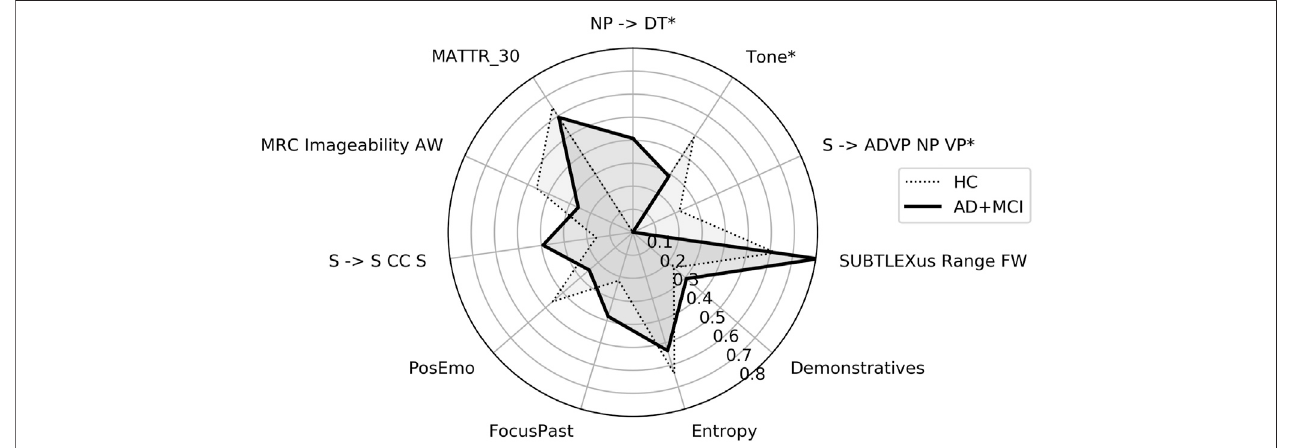
FIGURE2| RadarplotshowingfeaturesimportantforHCvs.AD+MCIclassi fi cationusingpicturedescription.HC (cid:1) healthycontrol,AD+MCI (cid:1) Alzheimer ’ sdisease and Mild Cognitive Impairment group. Features have been scaled to between 0 and 1 using MinMax scaling and medians plotted. * (cid:1) p < 0.05.